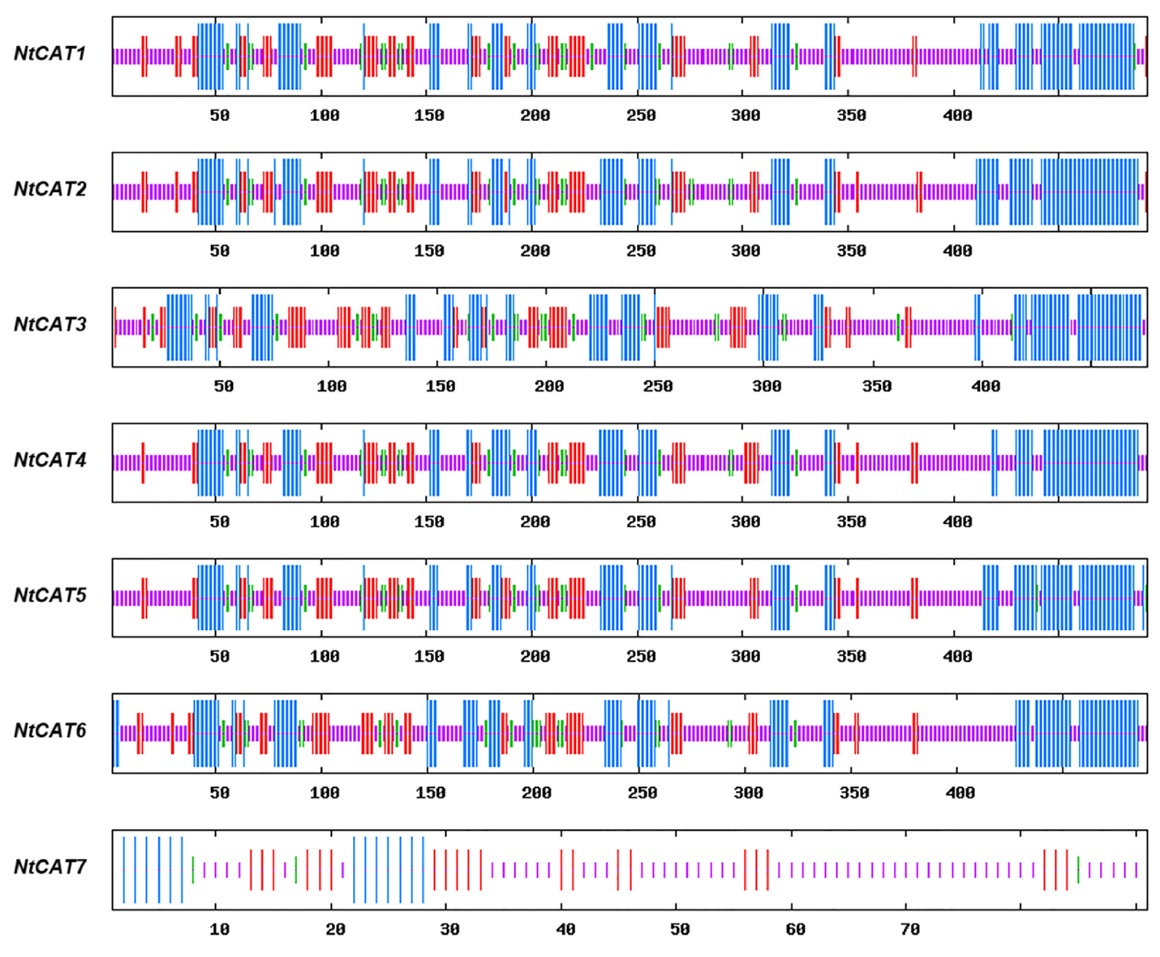
Figure 6. The secondary structure pattern—including alpha helix (blue color), extended strand (red color), beta turn (green color) and random coil (yellow color)—of NtCATs .